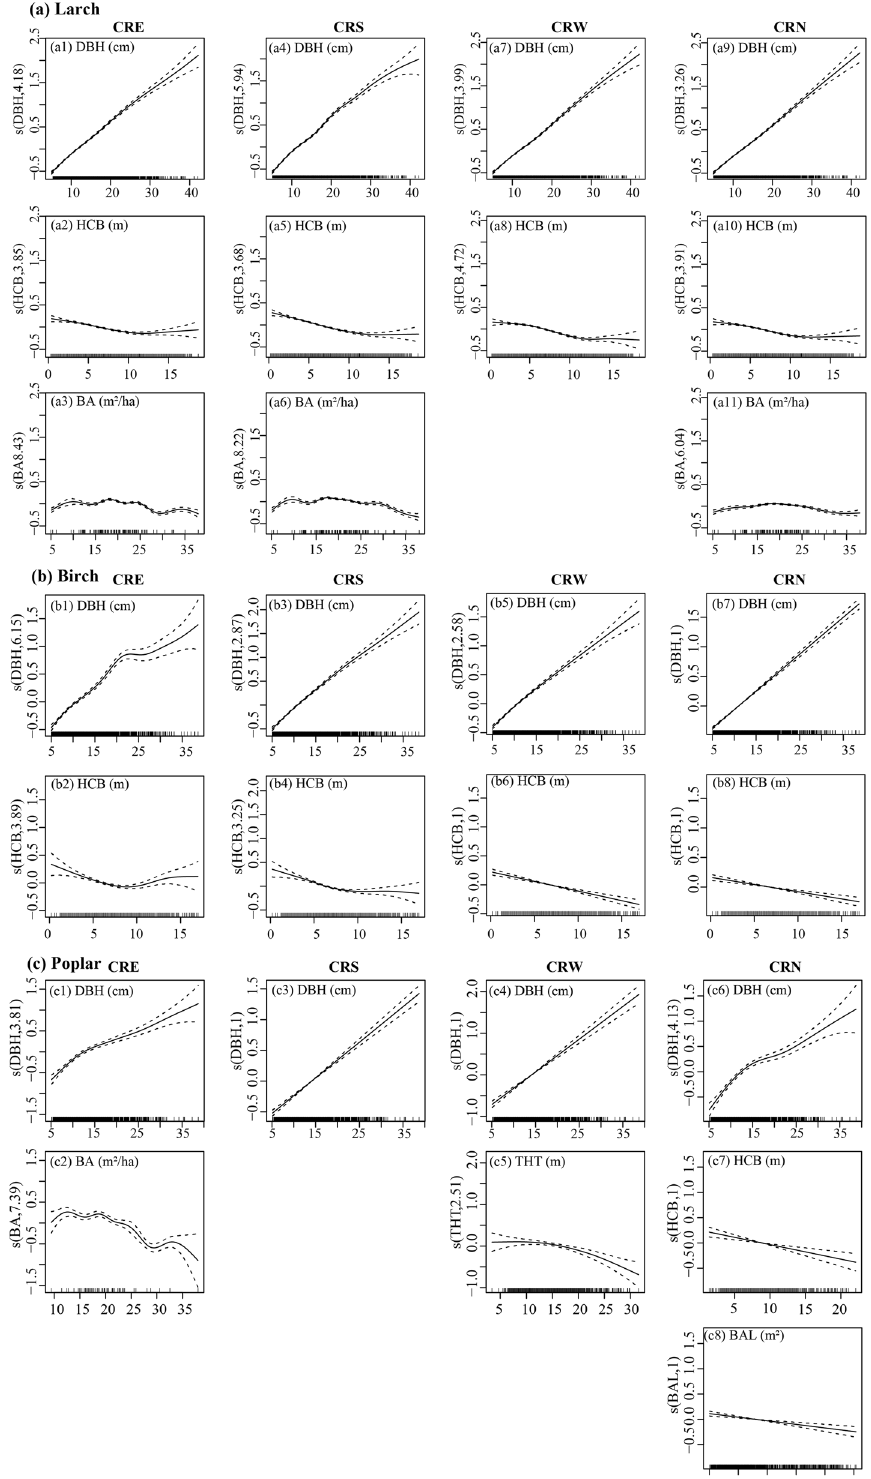
Fig. 5 Partial residual plots of covariables to each CR for a larch, b birch, and c poplar. The solid line in each plot is the estimate of the smooth function, while the dashed lines are roughly 95% confidence limits. At the base of each plot is a univariate histogram (rugplot) showing the distribution of data